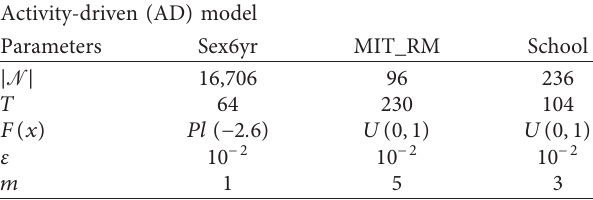
Table 3: The parameters of the activity-driven